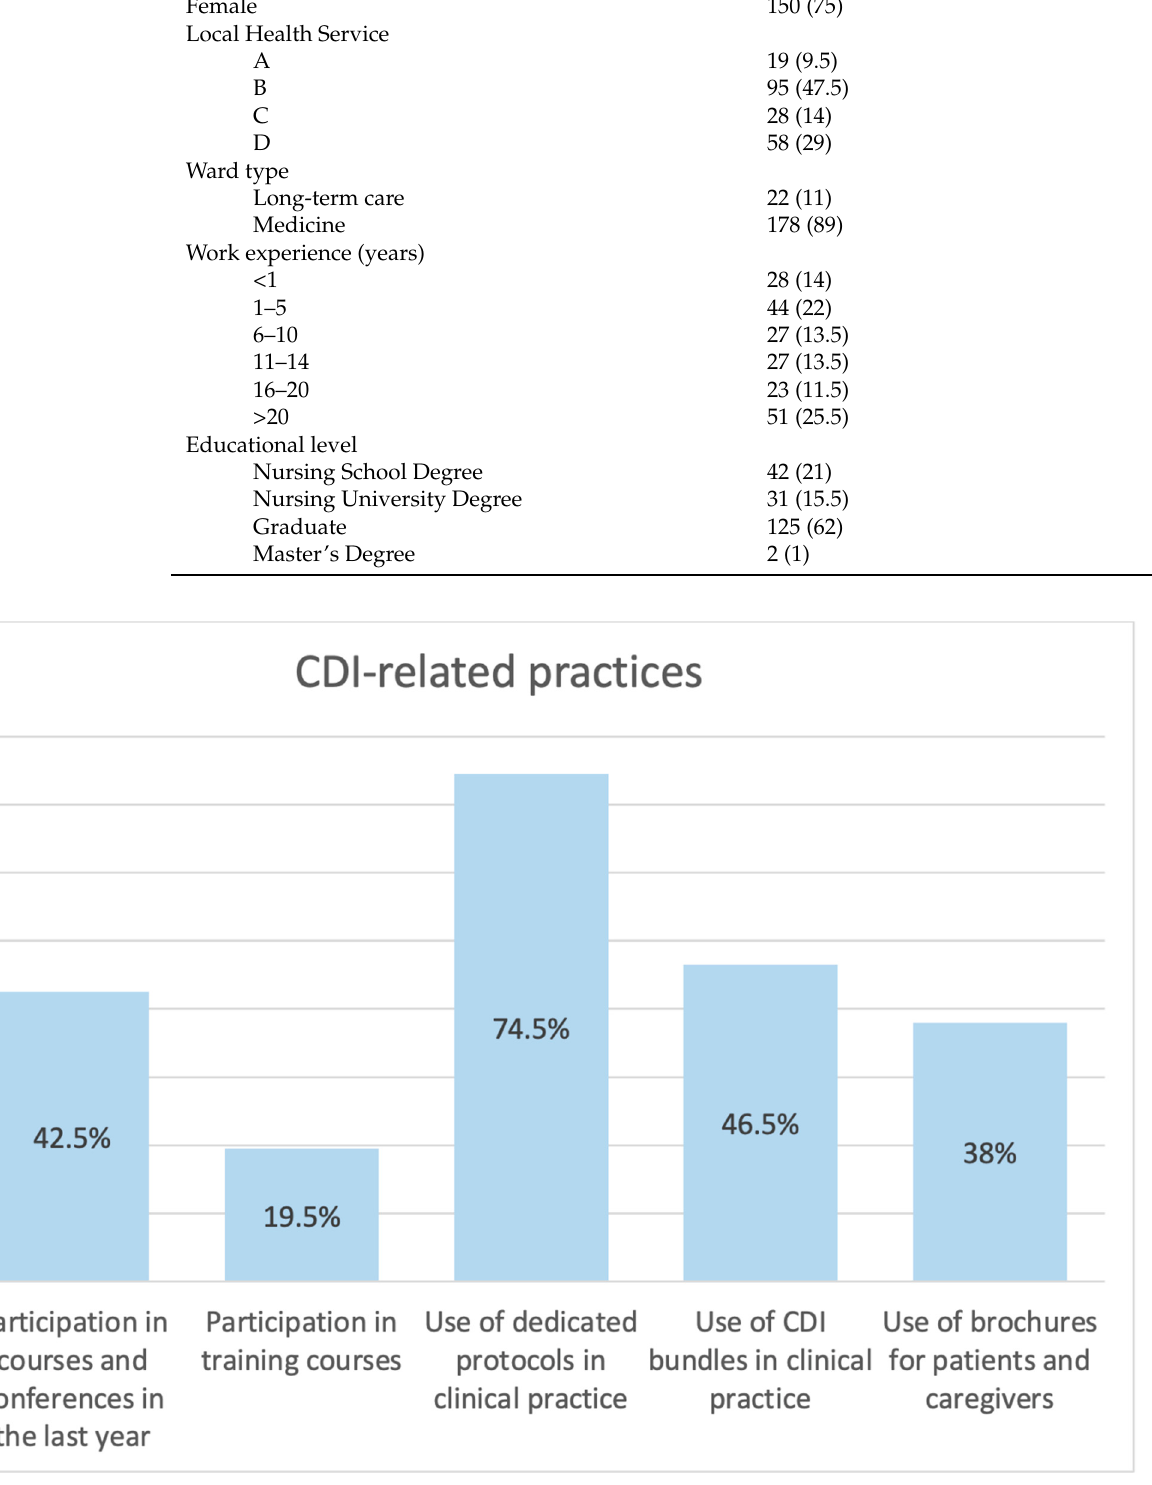
Figure 1. CDI-related practices. Histograms show the number of respondents who declared they had implemented the specific CDI-related practice on their daily professional activity. Percentages are reported in brackets.